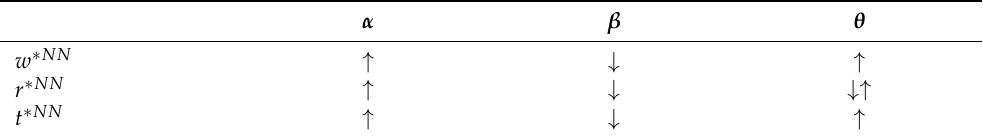
Table 3. The sensitivities of optimal operation policy to model parameters for Strategy